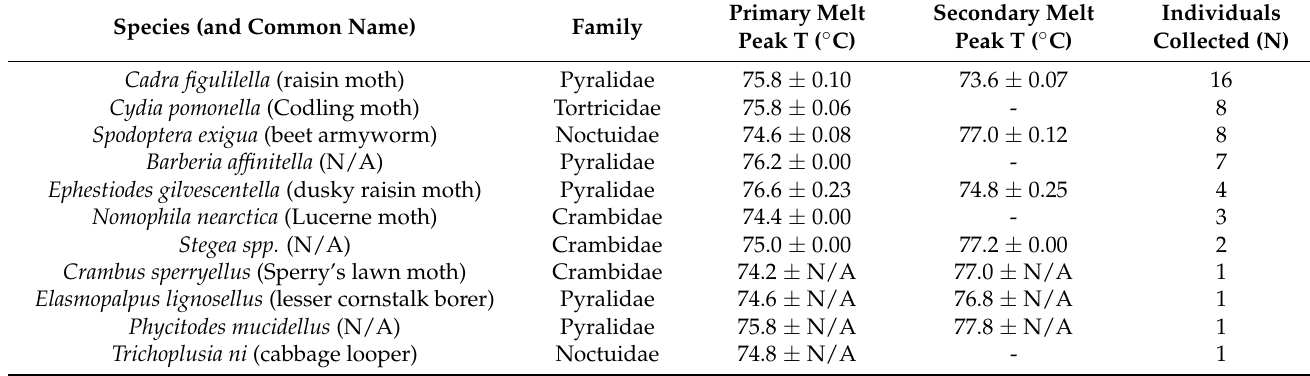
Figure 3. Melt peak chart showing melt profiles for PCR amplicons of the cytochrome oxidase subunit I gene from codling moth and the ten species collected from kairomone traps in almond orchards. Due to the large number of species being represented, only one representative individual is included per species to aid readability. Table 2. Melt peak profile for codling moth and the ten species collected from kairomone traps in almond orchards. Data include estimated melt peak temperature (T) for both primary and secondary peaks with 95% confidence interval and the number of individuals collected for each